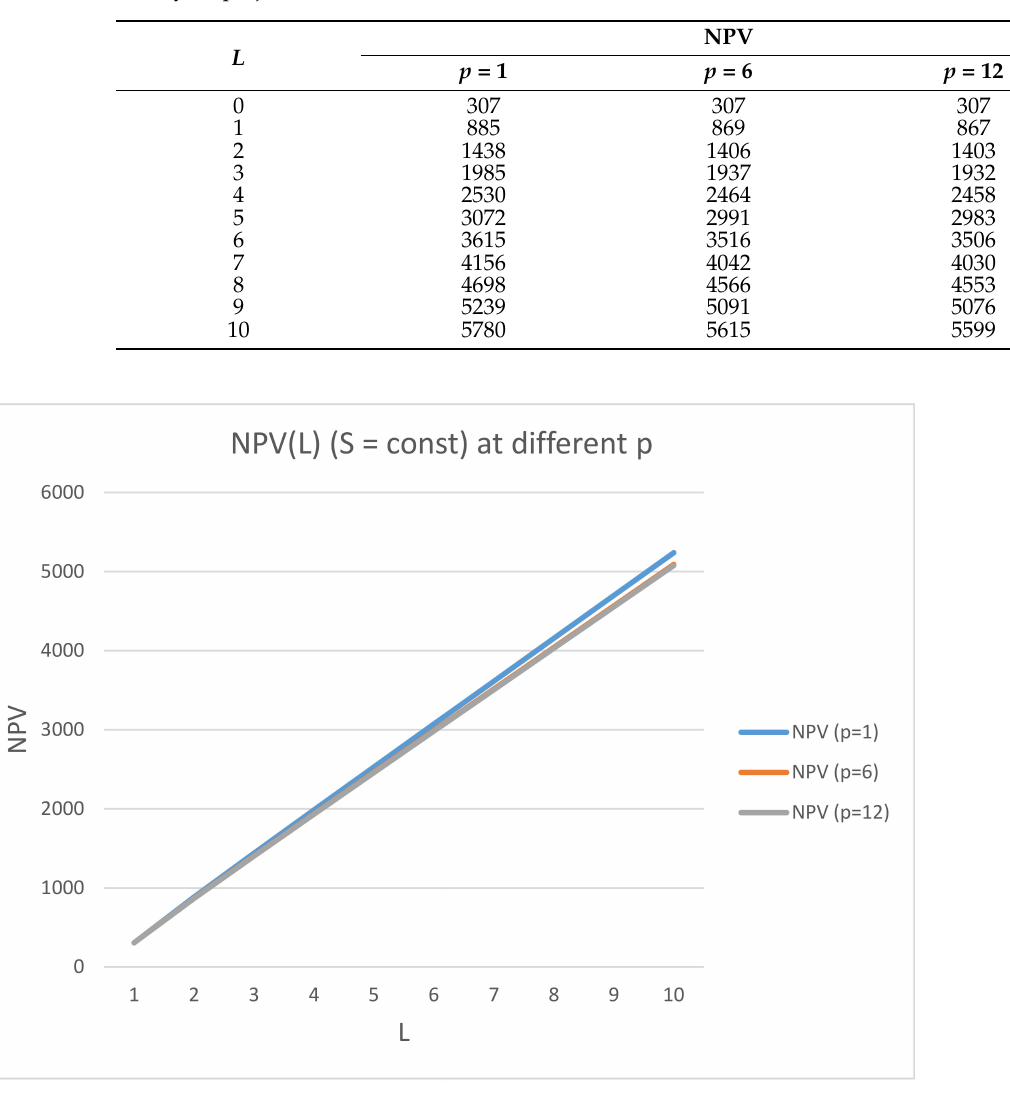
Table 5. Dependence of NPV on leverage level L at k 0 = 0.22, k d = 0.14 and different p = 1, 6, 12 for a three-year project.